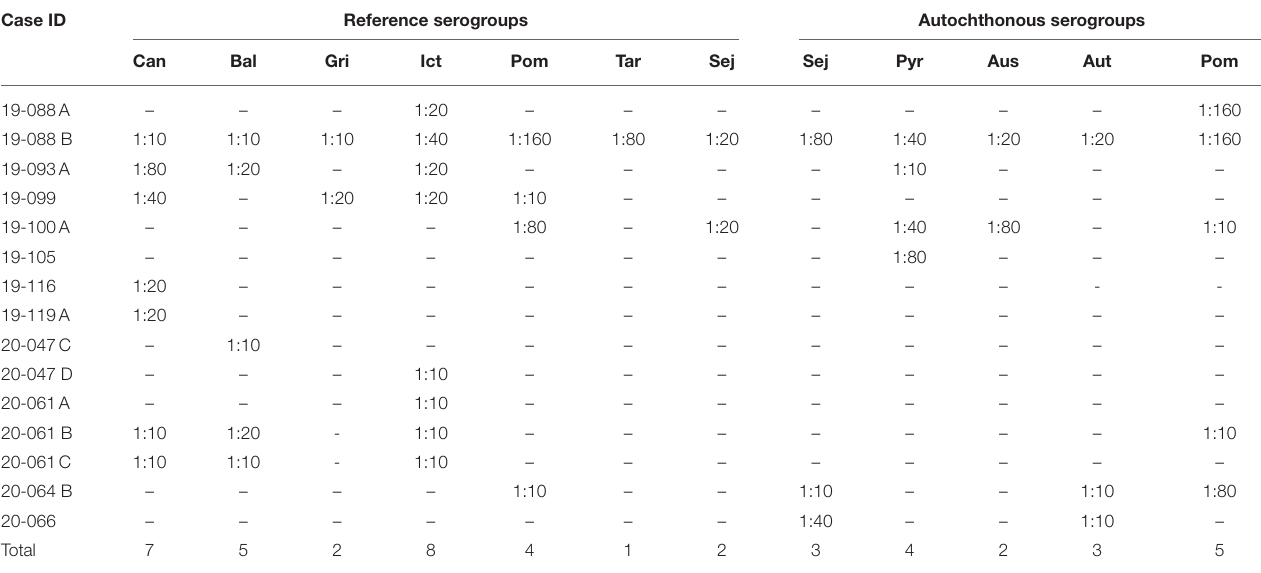
TABLE 3 | Fetal fluid samples seroreactive to microscopic agglutination test (MAT) performed using 12 Leptospira spp. serogroups and a cut-off titer of 1:10. Case